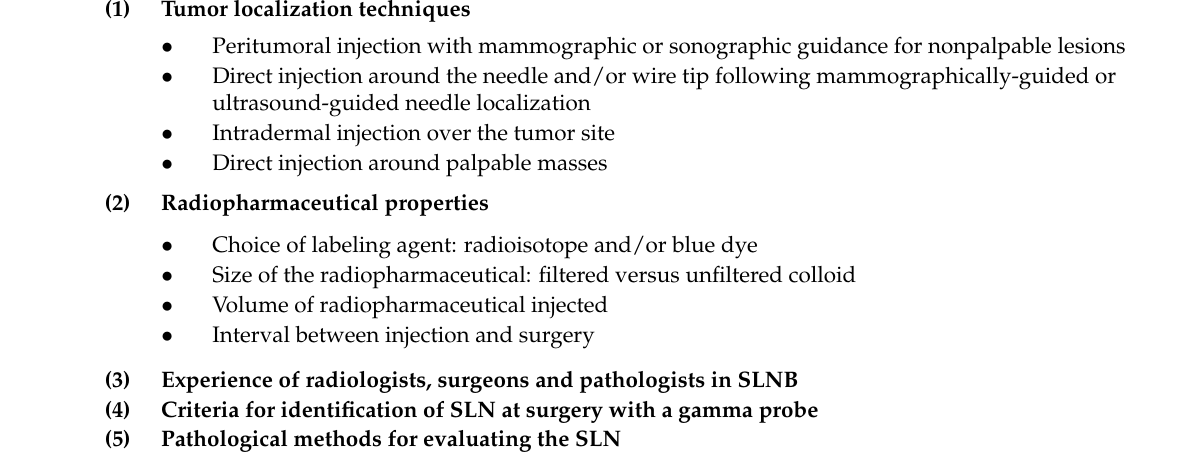
Table 1. Technical Factors in Sentinel Lymph Node Biopsy.